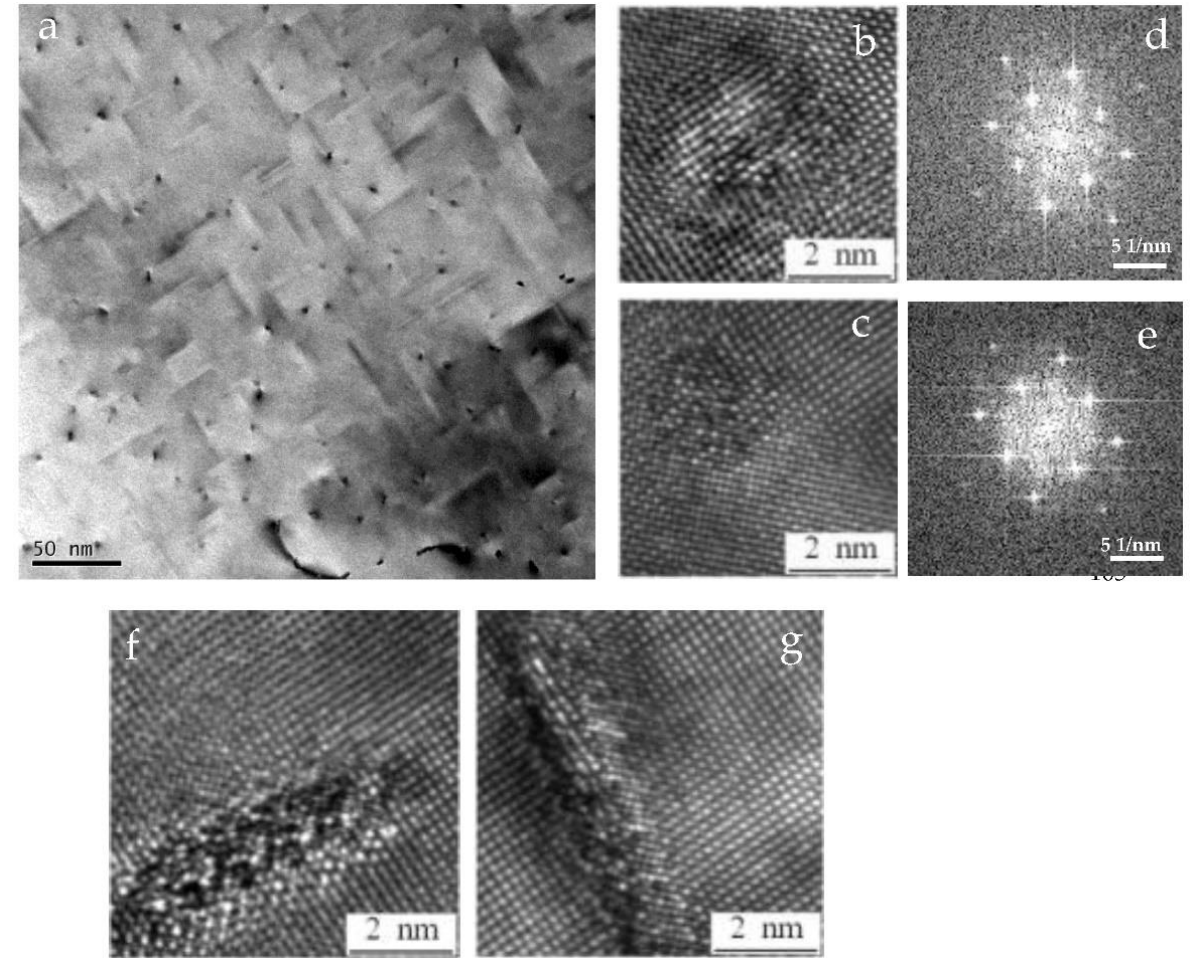
Figure 3. ( a ) Bright-field TEM images of the as-solutionized alloy aged at 180 °C for 1 h with zone axis [001] Al , ( b – e ) the HRTEM images of the cross-section of precipitates and the corresponding FFT of the HRTEM images, ( f , g ) the HRTEM images of the B’ precipitate. Figure 4 shows the bright-field TEM image (B = [001] Al ) of the alloy aged at 180 °C for 3 h. The length of the needle-shaped and the diameter of the cross-section precipitates increase when the aging time increased. The needle-shaped precipitates homogeneously distribute in the matrix and have a mean length of about 100 nm. In Figure 4b – d, HRTEM images illustrate the structure of precipitates, and the FFT is embedded in the corner of images. The shape of these precipitates is a parallelogram and nearly circular in cross- section view with [001] Al matrix direction. Based on the HRTEM observations, we speci- fied the following three types of precipitates (Figure 4b – d). The percentage of these types of precipitates in Figure 4b (2 × 4 nm) and Figure 4c (2 × 3 nm) is high, while the proportion of the precipitate in Figure 4d (3.5 × 7 nm) is minimal. The precipitates in Figure 4b,c are still pre- β′′, and the shape and size of the precipitates have changed compared with the precipitates in Figure 3. The lattice fringes intersect angle in Figure 4c is 77°. The appear- ance of the precipitates and the streaks on the FFT agrees with previous observations for β′′ precipitates [7,18]. It indicates that a small number of pre- β′′ phases have transformed into β′′ as increasing aging time to 3 h.